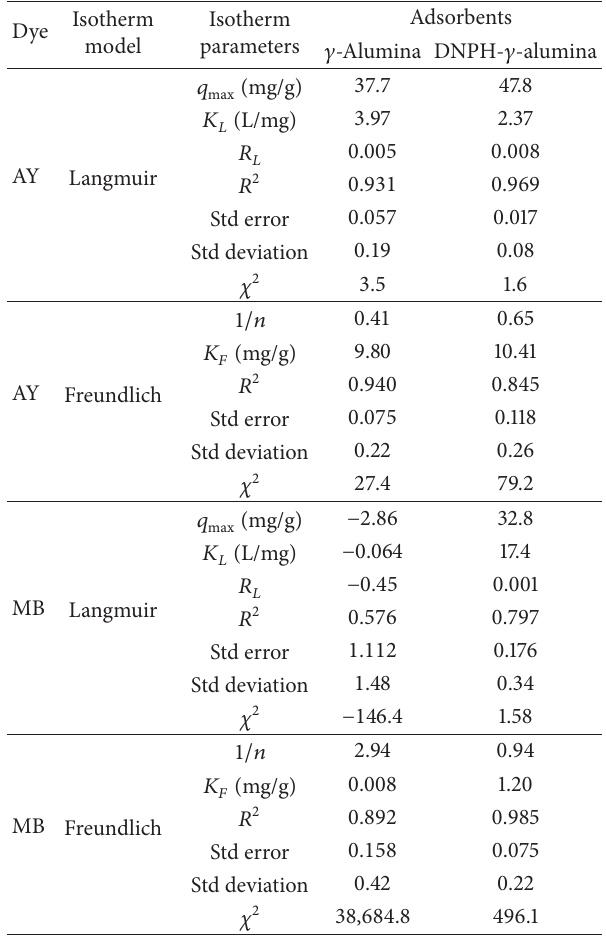
Table 2: Adsorption isotherms and their statistical comparison